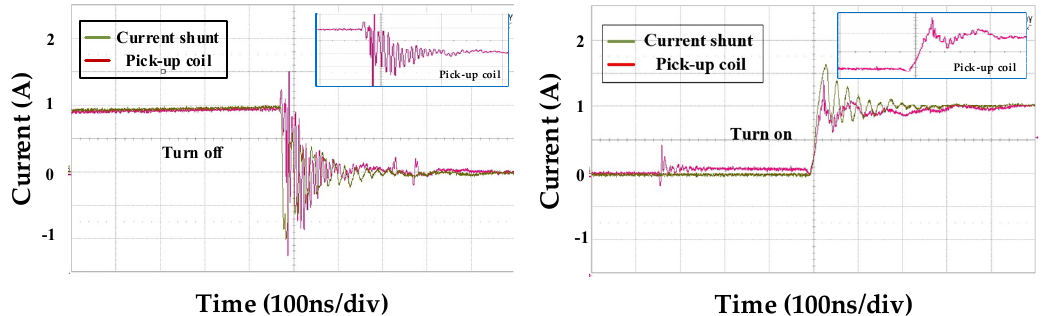
Figure 12. Comparison between measured integrator output waveforms of the two-layer rectangle coil integrator output and shunt resistor sensor at dc link voltage V dc of 250 V.